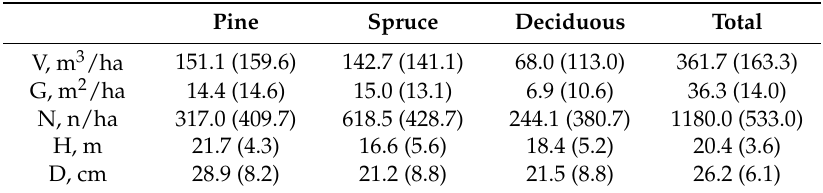
Table 1. Field sample data statistics, mean values and (standard deviations). n = 281. V = total volume, G = basal area, N = stem number, H = tree height, D = breast height